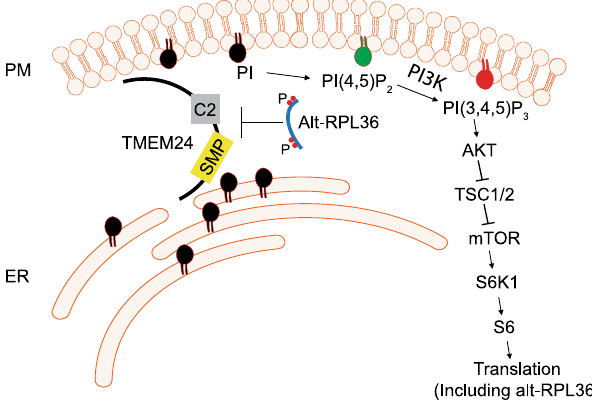
Fig. 8 Model of alt-RPL36 regulatory pathway. Phosphorylated (P) alt- RPL36 interacts with TMEM24 via the SMP and C2 domains to negatively regulate TMEM24-dependent phosphatidylinositol 4,5-bisphosphate [PI (4,5)P 2 ] precursor phosphatidylinositol (PI) transport. In cells lacking alt- RPL36, TMEM24 is released from the inhibition by alt-RPL36, and more PI is transported to the plasma membrane (PM) from the endoplasmic reticulum (ER), where it is synthesized. At the PM, PI is converted to PI (4,5)P 2 then phosphorylated by PI3K to produce PI(3,4,5)P 3 . PI(3,4,5)P 3 then activates AKT, which phosphorylates and inhibits TSC1/2, then activates downstream mTOR signaling. mTOR phosphorylates S6K1, and activated S6K1 phosphorylates S6, fi nally upregulates protein translation, including alt-RPL36. Upregulated alt-RPL36 then inhibits TMEM24, restoring